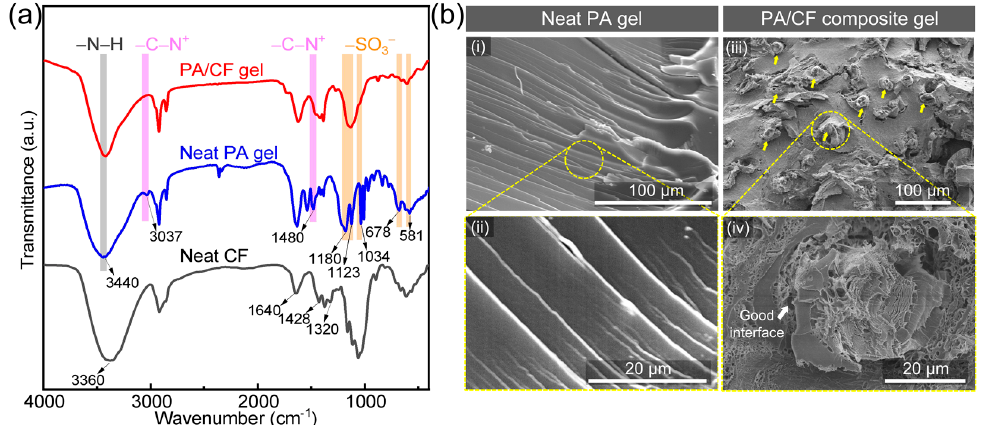
Figure 2. Structural characterizations of neat PA hydrogel and PA/CF composite hydrogel. ϕ CF = 6.0 wt%. ( a ) FTIR spectra of the samples. Yellow, pink, and gray bars indicate the peaks of − SO 3 ̶ , − (CH 3 ) 3 N + , and − NH − groups, respectively. ( b ) SEM images of the fractured samples. Yellow arrows in ( iii ) indicate the existence of fractured fibers in the hydrogel matrix.